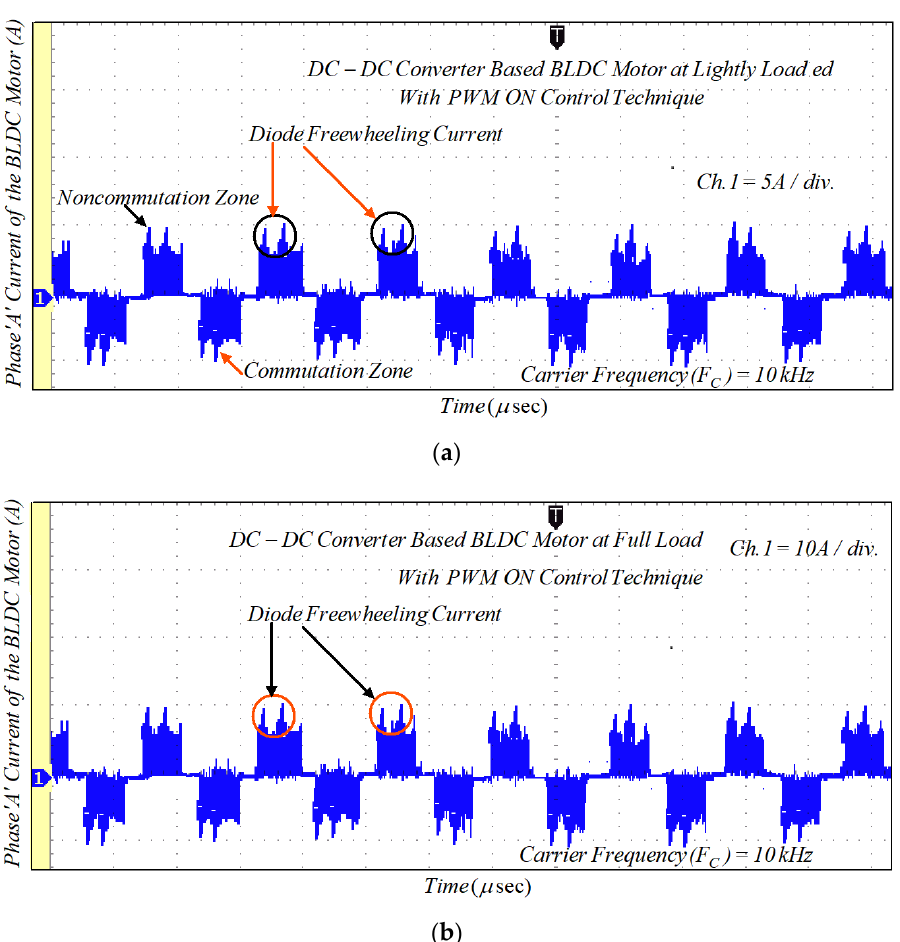
Figure 19. Experimental results of motor current with PWM-ON technique: ( a ) lightly loaded condition, 2 A/div.; and ( b ) full load, 5 A/div.